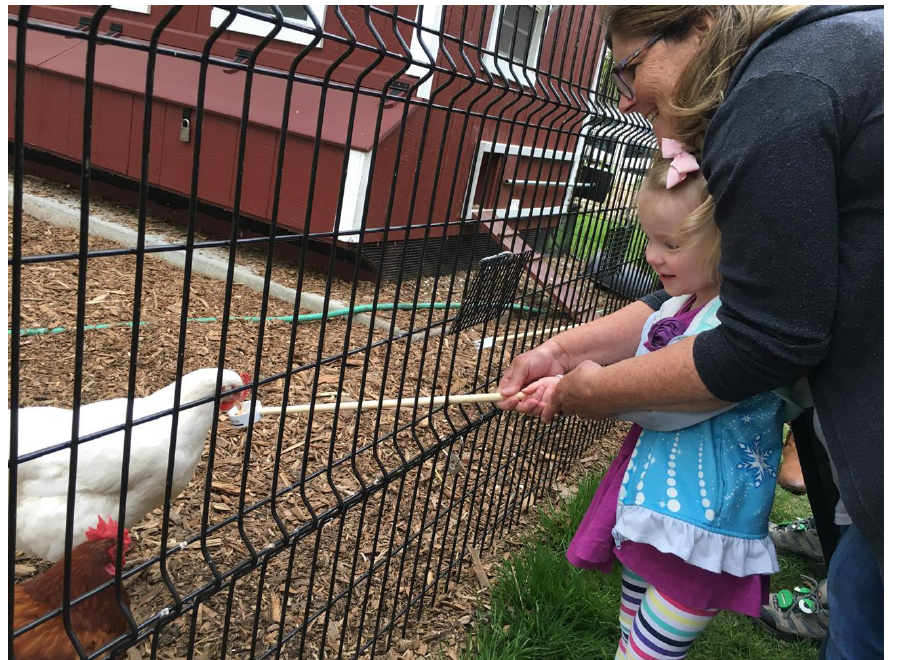
Visitors Participating in Feed-the-Chickens